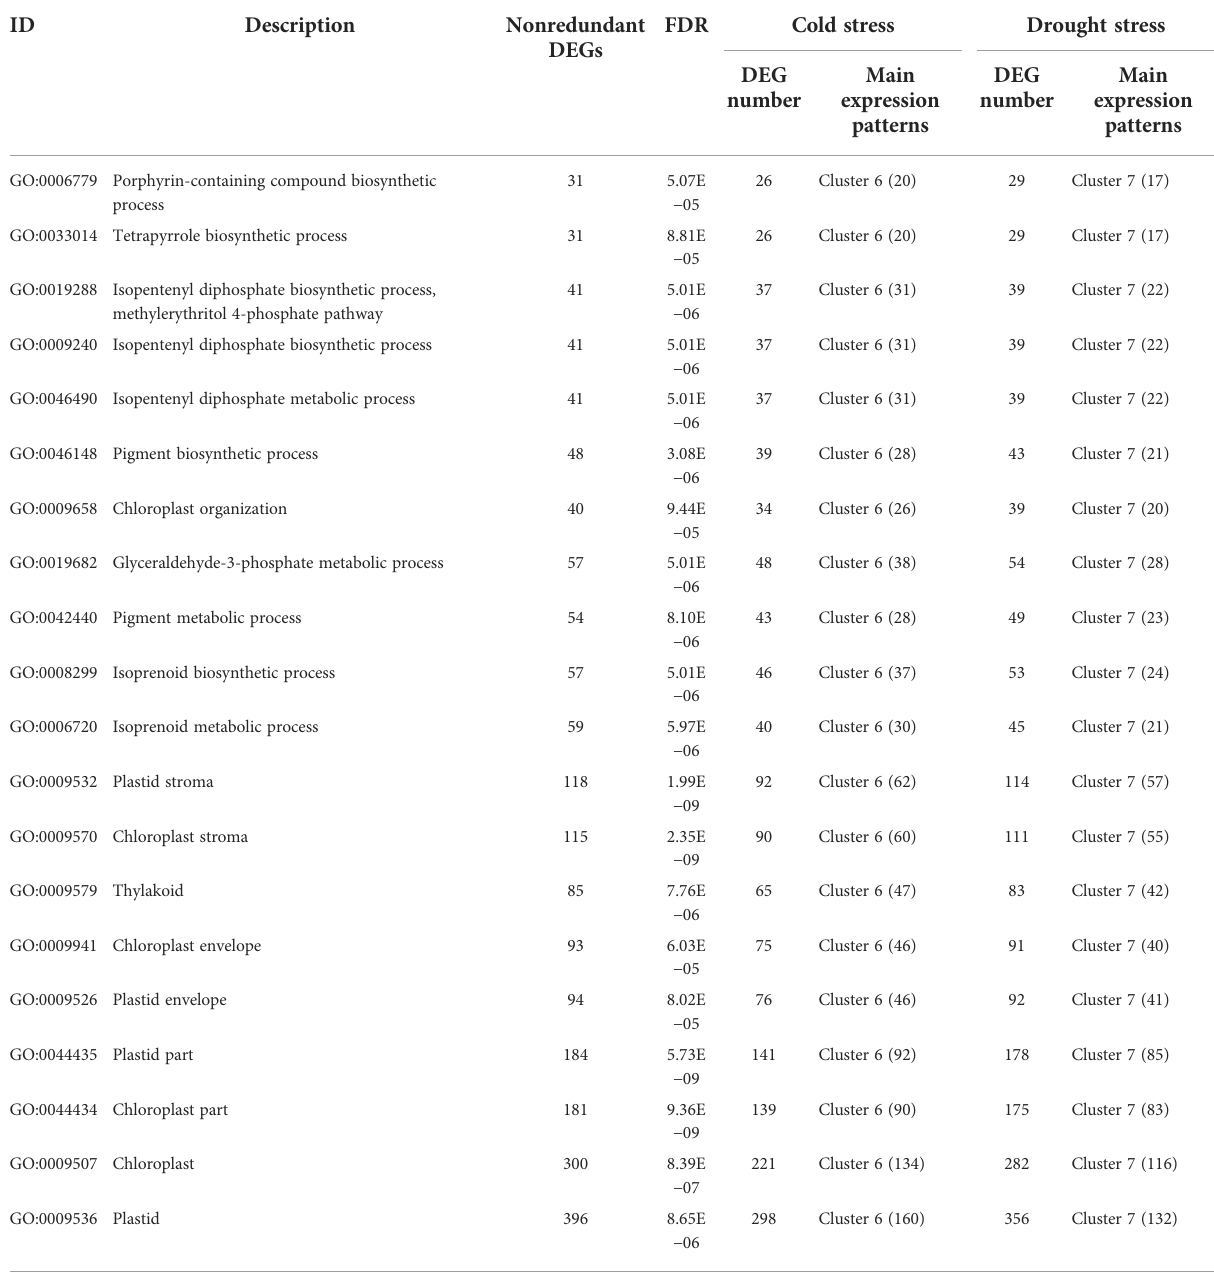
TABLE 2 The GO functions of the core genes in consensus modules between cold and drought.